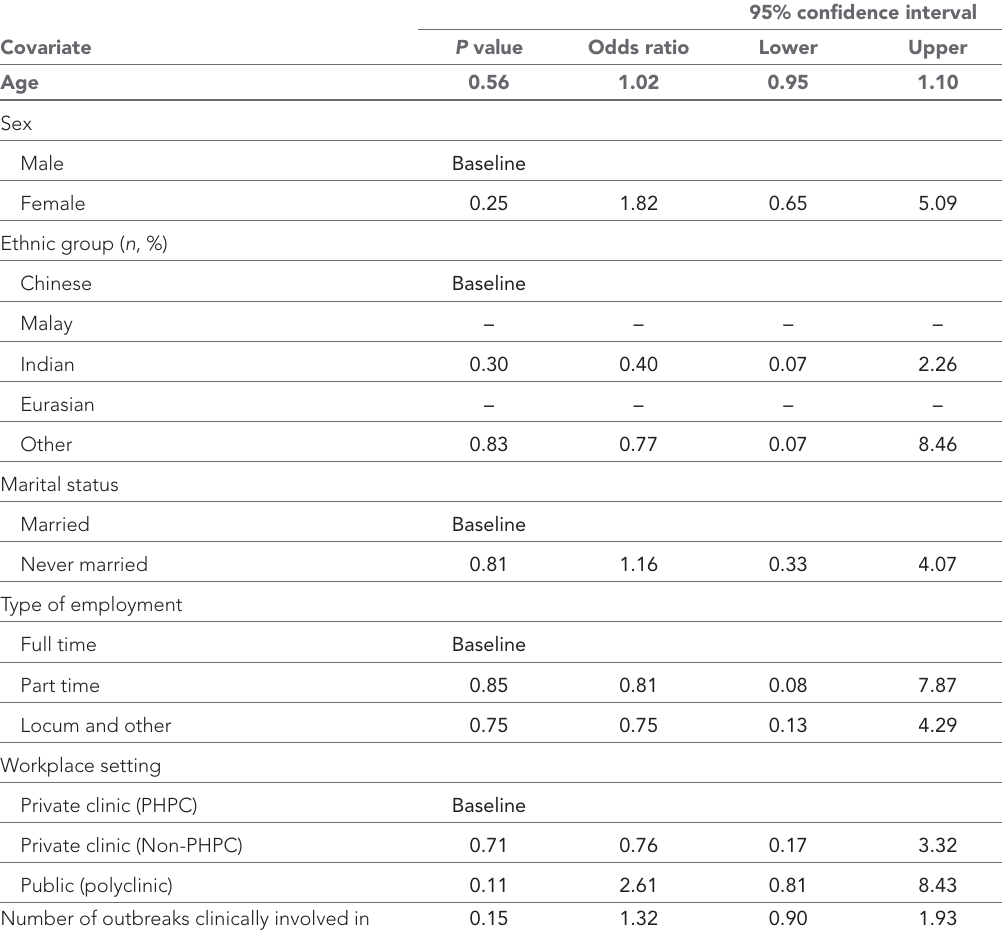
Table 5 Sociodemographic and work environment correlates of post- traumatic stress disorder